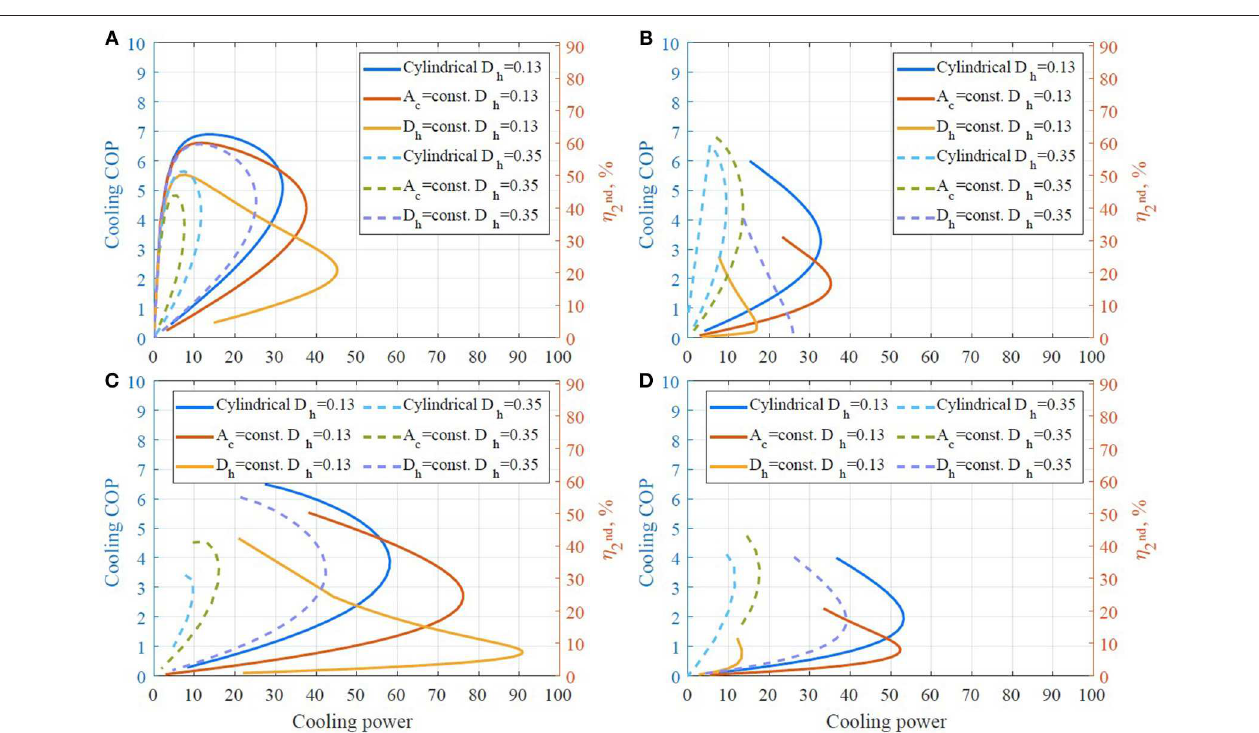
FIGURE 10 | Cooling COP as a function of cooling power at ε = 0.45. (A) Cassette 1, ν = 0.5Hz, (B) cassette 2, ν = 0.5Hz, (C) cassette 1, ν = 2Hz, (D) cassette 2, ν = 2Hz.